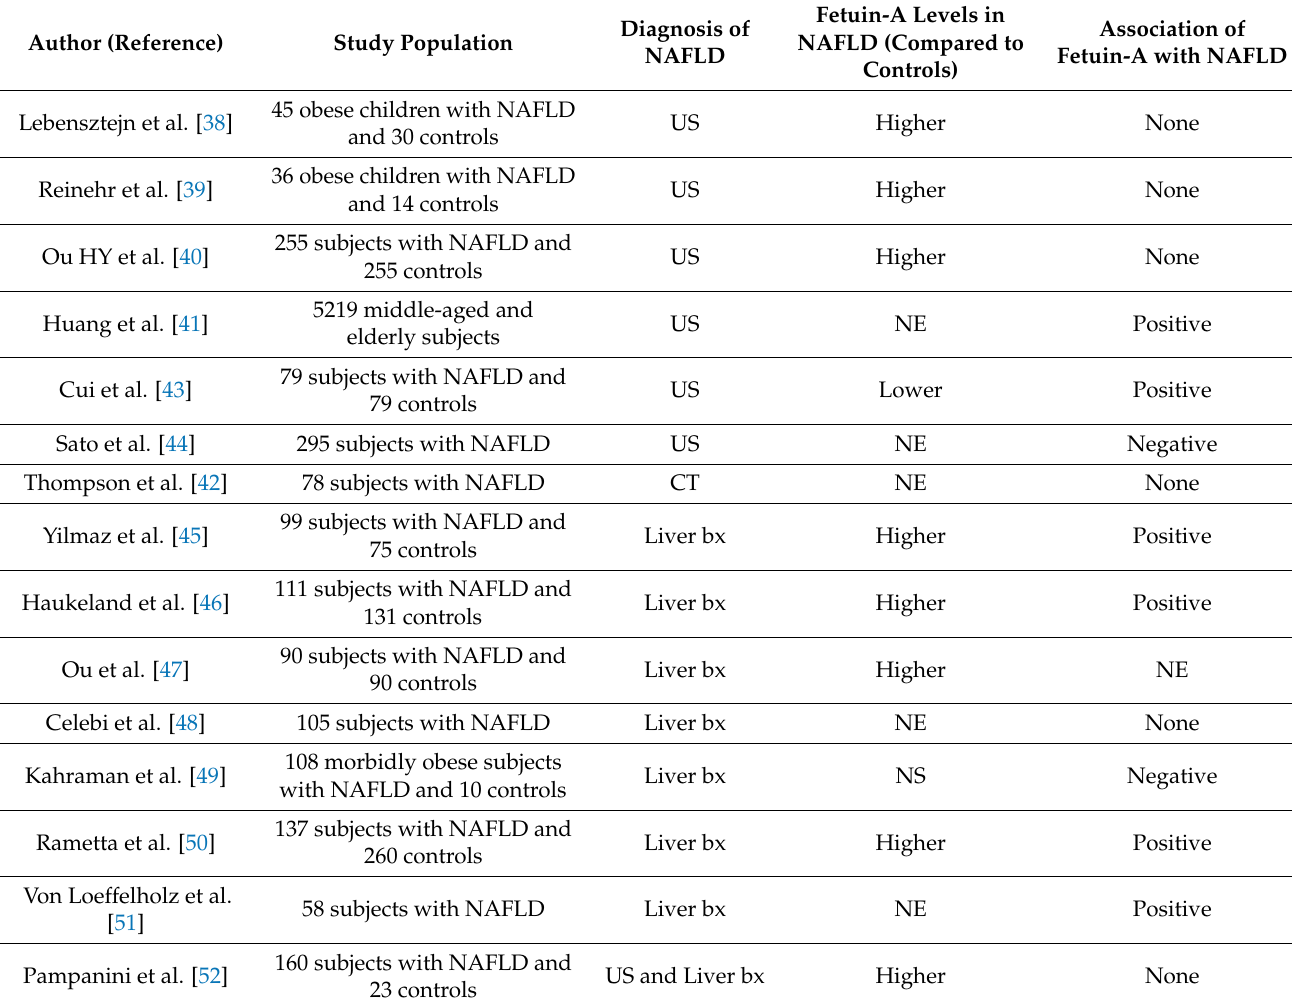
Table 1. Studies investigating circulating fetuin-A levels in subjects with